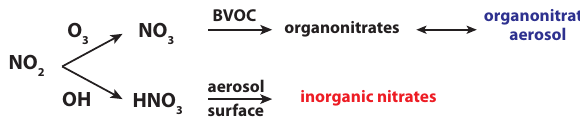
Scheme 1. Generalized reaction fate for NO 2 in the troposphere. Oxidation of NO 2 from atmospheric oxidants leads to two possible